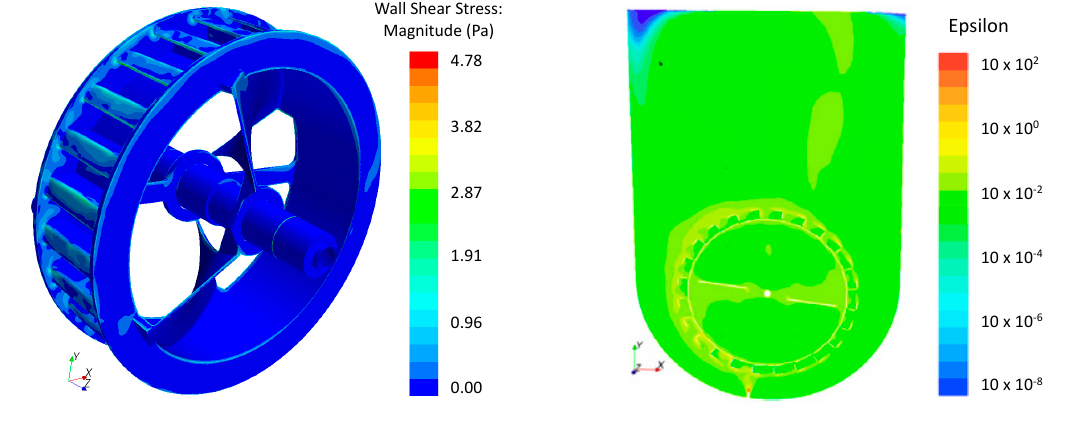
Figure 1. Computational fluid dynamics (CFD) analyses of shear stress on the surface of vertical-wheel impeller and range of turbulent energy dissipation rates in U-shaped vessel.